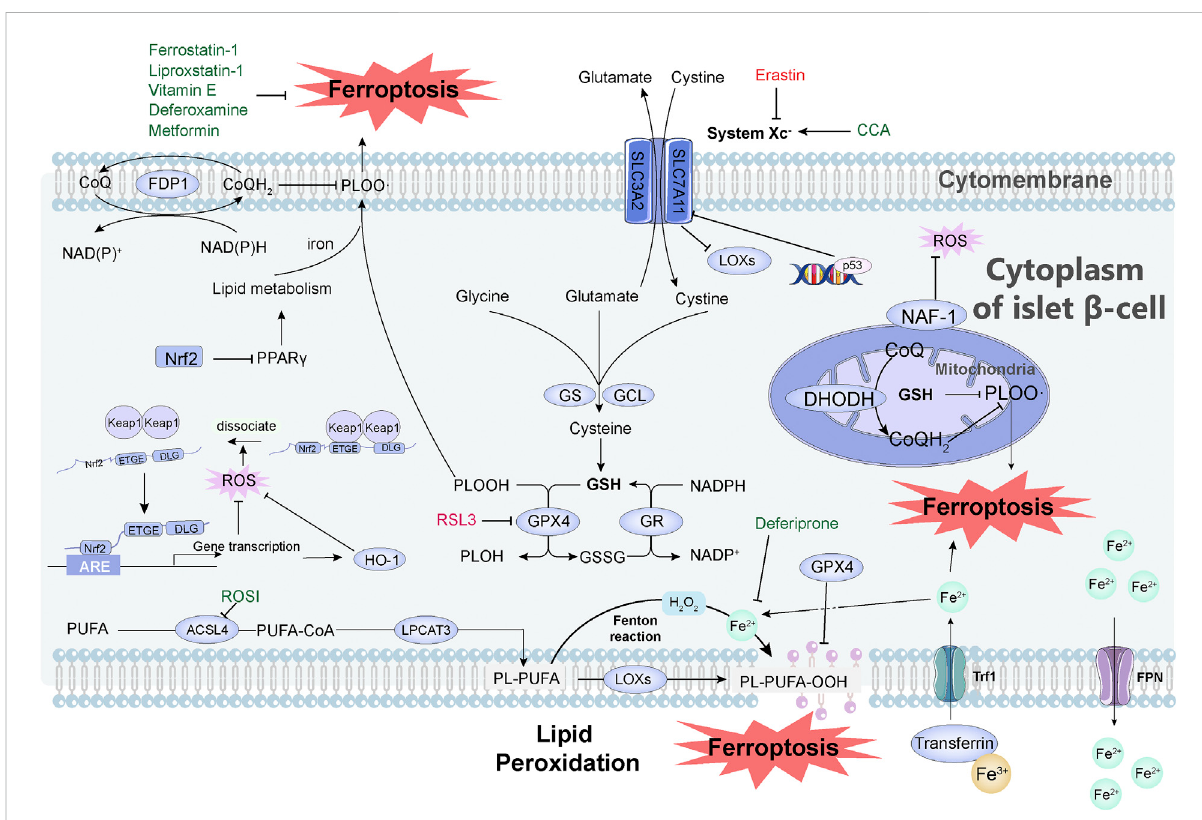
Mechanisms of how ferroptosis occurs and how it is inhibited in pancreatic islet cells. System Xc - is a cystine/glutamate antiporter system consisting of SLC7A11 and SLC3A2. After cystine enters the cell, it is reduced to cysteine, which becomes the raw material for the synthesis of GSH, and GSH becomes the reducing cofactor of GPX4. Glutamate cysteine ligase (GCL) and GSH synthase (GS) are the rate-limiting enzymes in the GSH biosynthesis pathway. DHODH is involved in the regulation of ferroptosis independent of GSH pathway. FSP1 reduces CoQ through NAD(P)H, thereby reducing lipid free radicals and thereby inhibiting ferroptosis. Iron ions entering the cells undergo the Fenton reaction, which causes the peroxidationofPUFAstogeneratelipidperoxides,resultinginthedestructionofthecellmembranestructureandtheoccurrenceofferroptosis.This peroxidation is regulated by three synthetases: ACSL4, LPCAT3, and LOX. Transferrin imports iron from the extracellular environment to the intracellular state through TfR1 recognition, and excess iron is stored in the form of bound ferritin and transported to cells under the action of FPN1. Transferrin imports Fe 3+ (yellow ball) from the extracellular environment to the cytoplasm of islet β -cell through TfR1 recognition, and then Fe 3+ is converted to Fe 2+ (light green ball). The excess iron is stored in the form of bound ferritin and fi nally ef fl uxed by FPN. Activation of p53 severely reduced the protein level of SLC7A11 and thus mediated ferroptosis. When the organism is under oxidative stress, Nrf2 dissociates from Keap1 and interactswiththeAREoftargetgenestomaintaincellularredoxhomeostasis.TheNrf2-HO-1pathwaycanmodulateintracellularironconcentration to suppress ferroptosis. Nrf2 inhibits ferroptosis directly through the PPAR γ pathway. Small molecules in green in the fi gure can inhibit ferroptosis, including:VitaminE, Metformin,Deferoxamine,Liproxstatin-1, Ferrostatin-1, Deferiprone,CCA,ROSI.Smallmoleculesinredcaninduceferroptosis, including Erastin and RSL3. Abbreviation, System Xc - , a cystine/glutamate antiporter system; GSH, glutathione; GPX4, glutathione peroxidase; GCL, glutamate cysteine ligase; GS, GSH synthase; RSL3, RAS-selective lethal 3; DHODH, dihydroorotate dehydrogenase; FSP1, ferroptosis suppressor protein 1; CoQ, coenzyme Q; PUFAs, polyunsaturated fatty acids; ACSL4, acyl-CoA synthetase long-chain family member 4; LPCAT3, lysophosphatidylcholine acyltransferase 3; LOX, lipoxygenase; TfR1, transferrin receptor 1; FPN1, ferroportin; ARE, antioxidant response element; CCA, cryptochlorhydric acid; ROSI,